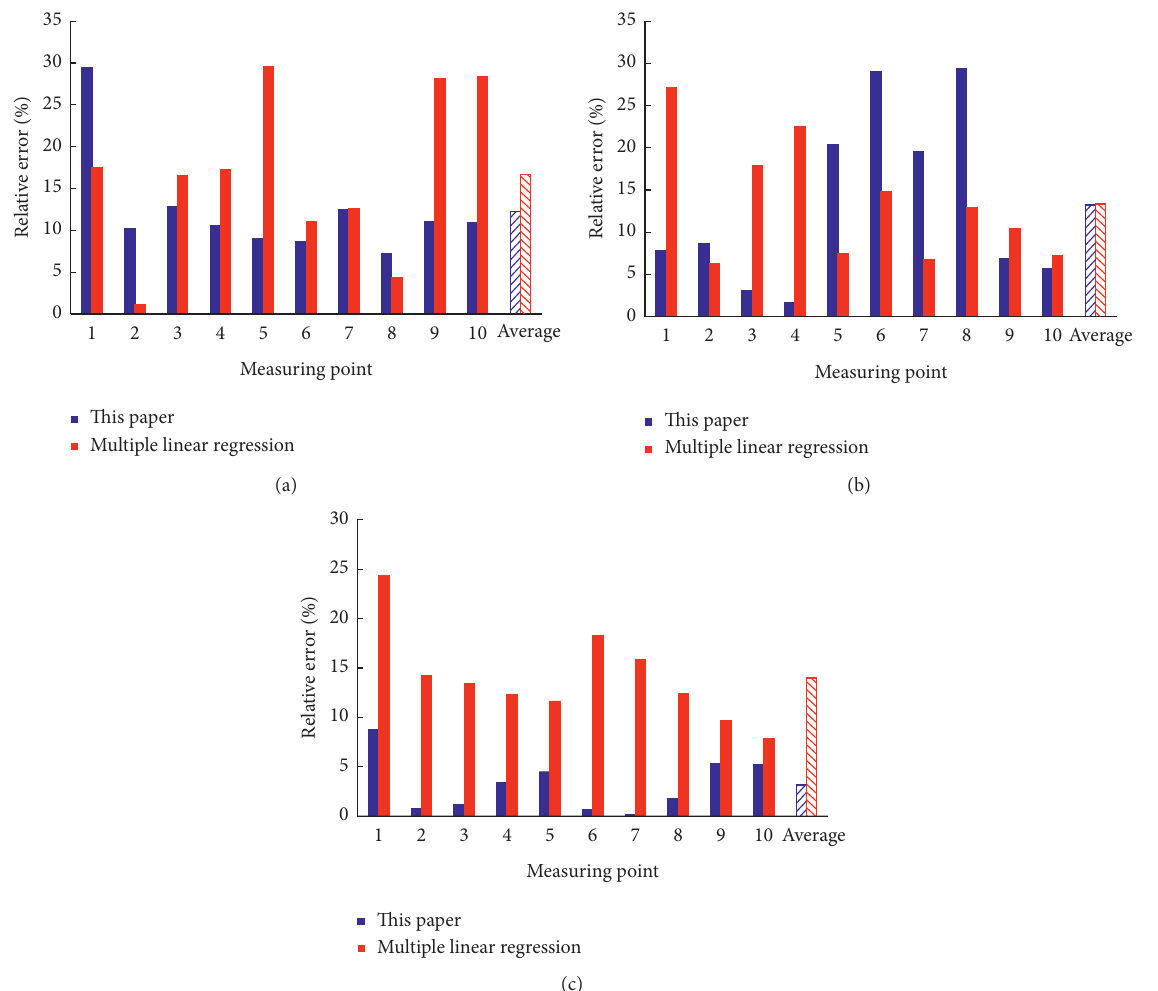
Figure 12: Comparative analysis of the relative error between two methods. (a) ε